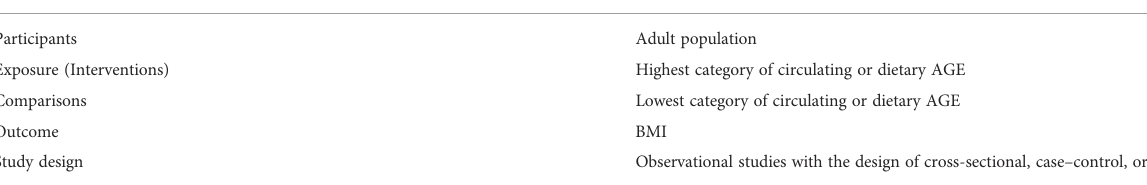
TABLE 1 The PICO criteria used for the systematic